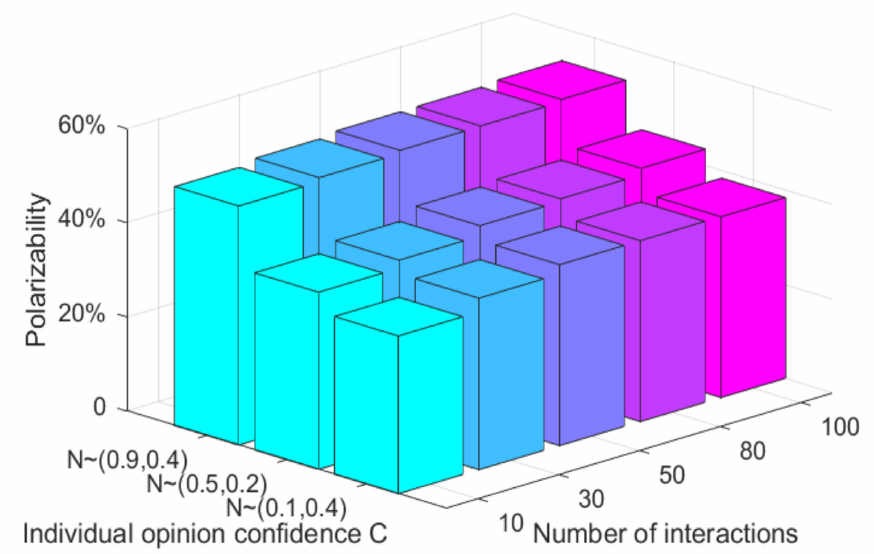
Figure 11. The relationship of individual viewpoint confidence, individual interaction times and attitude